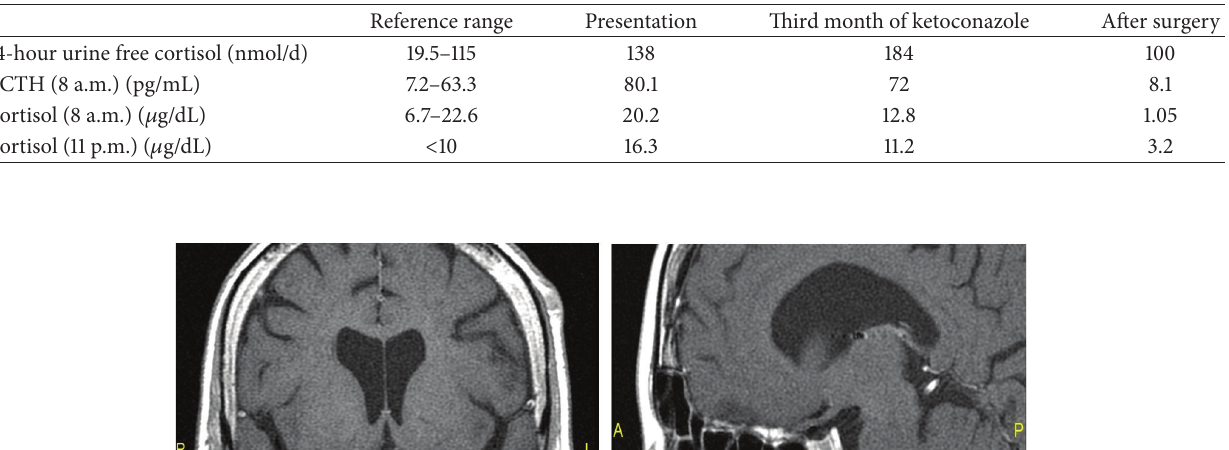
Table 1: Laboratory investigation results.